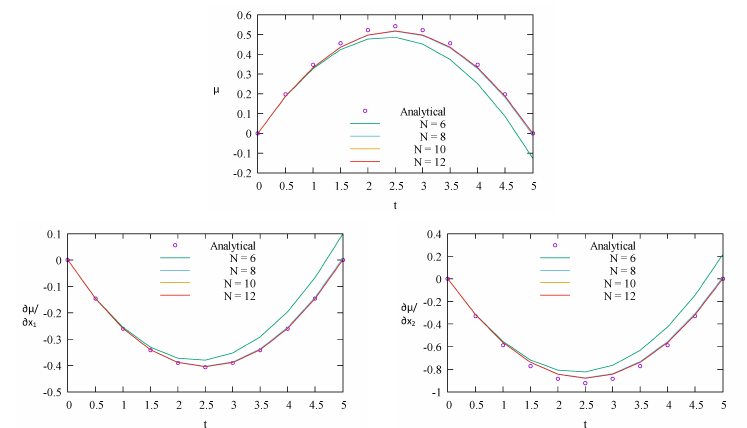
Figure 7. The solutions µ , ∂µ/∂x 1 and ∂µ/∂x 2 at ( x 1 ,x 2 ) = (0 . 5 , 0 . 5) for Case